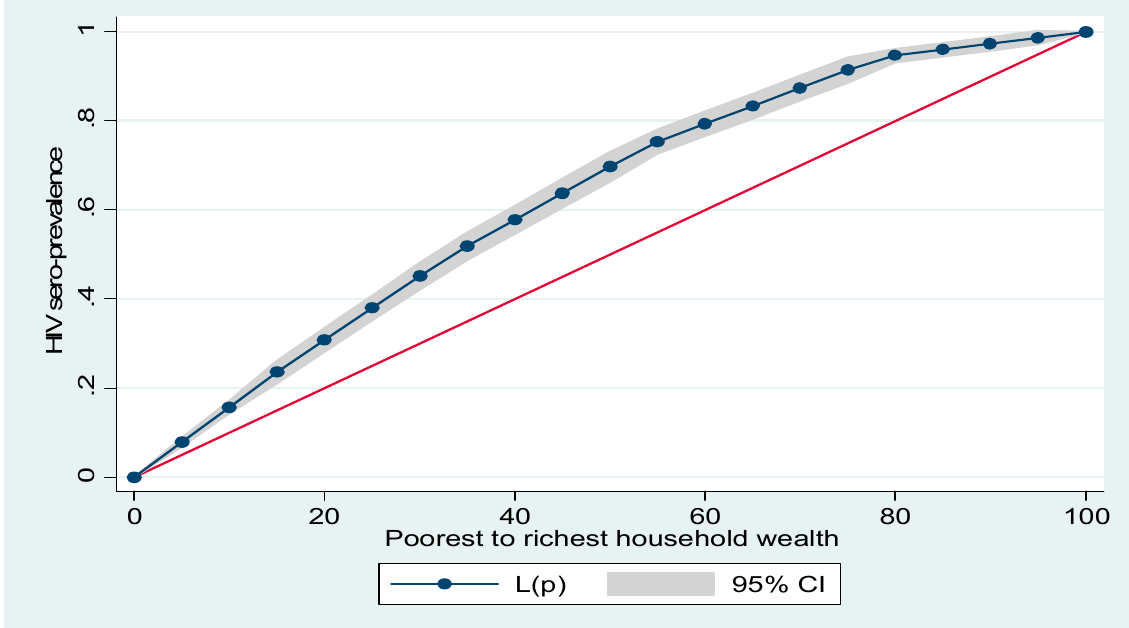
Figure 1. Lorenz curve for HIV prevalence by women’s household wealth.